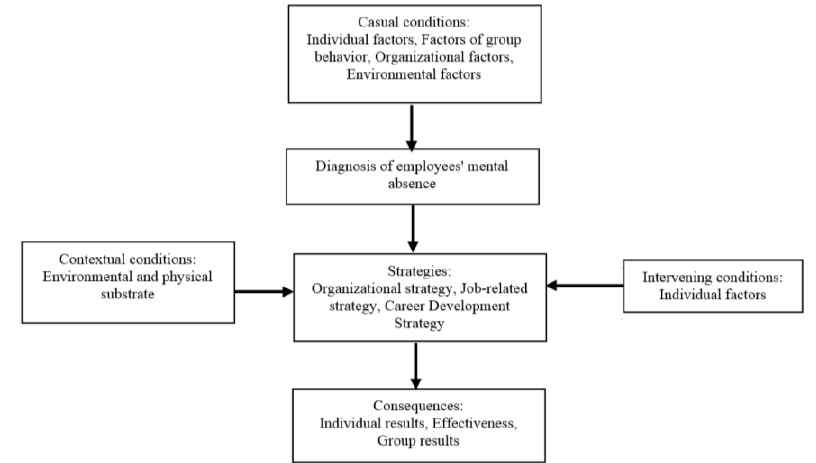
Figure 1: Conceptual research model (Atlas TI's